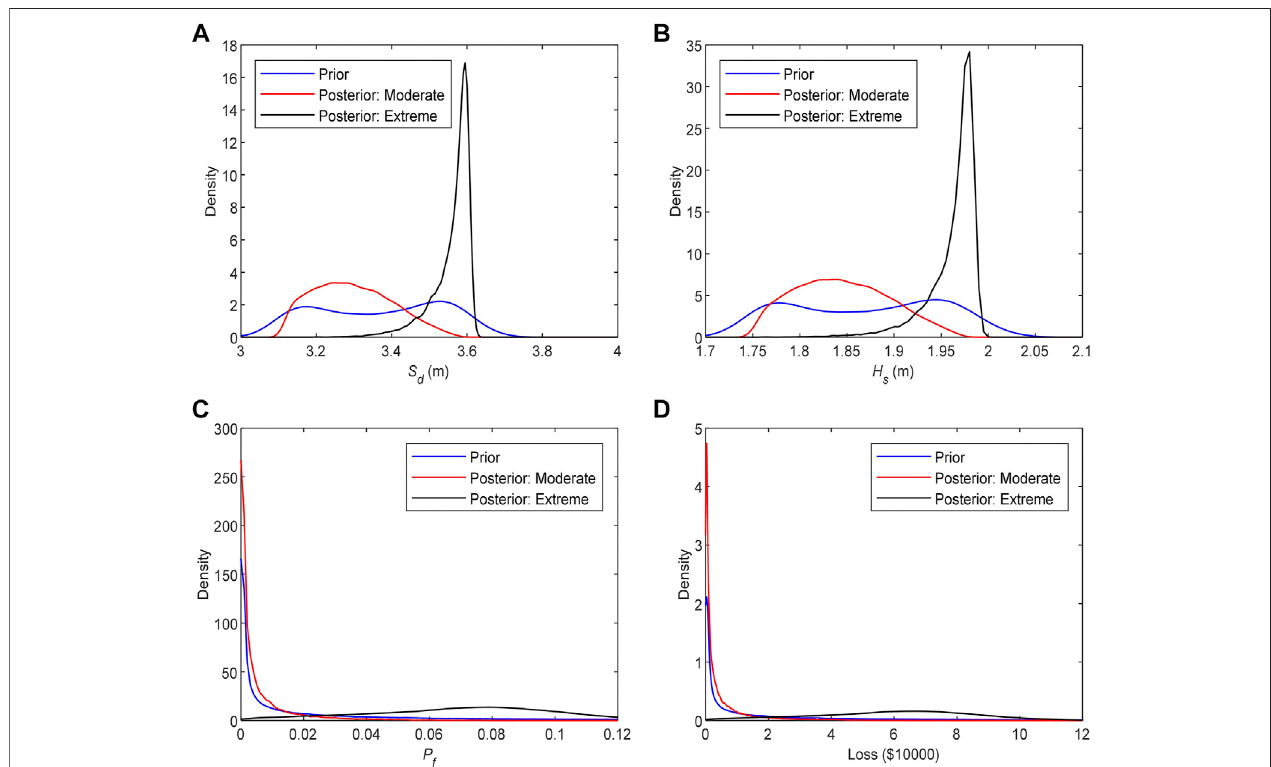
FIGURE 8 | The effect of different sets of evidence (moderate vs. extreme climate scenario) in the marginal posterior distribution of the loss for the year 2050.